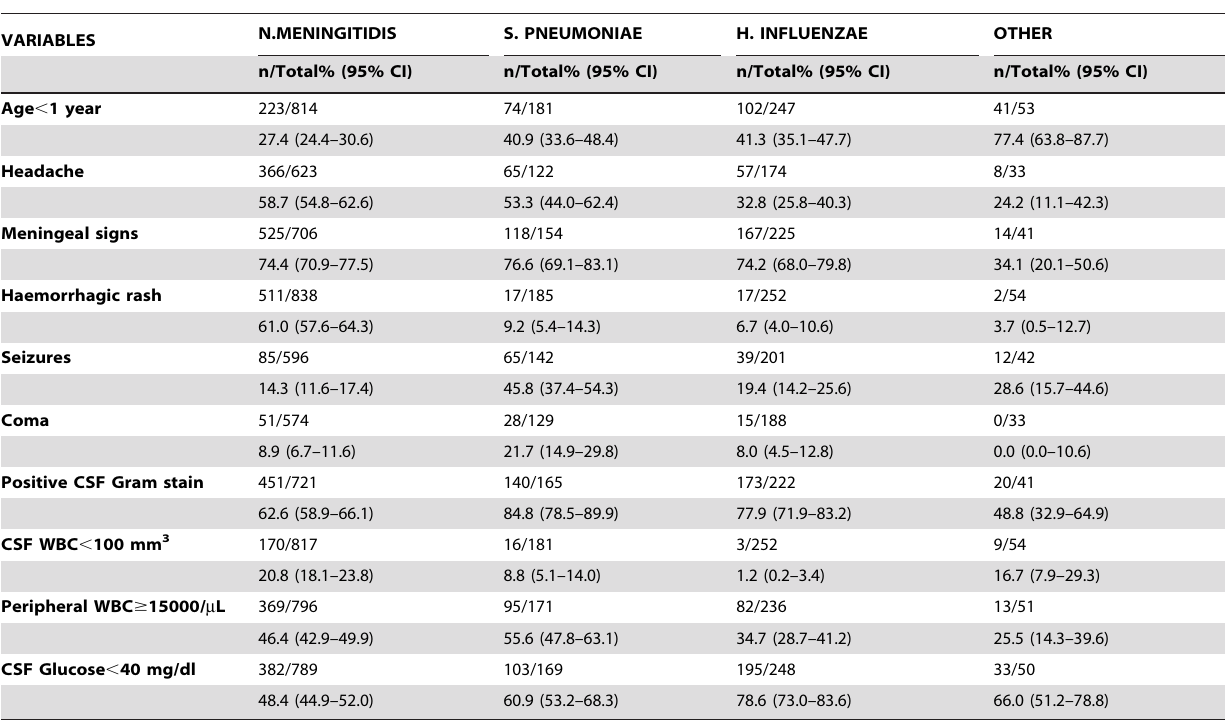
Table 3. Frequency of clinical and laboratory findings for specific bacterial pathogen.